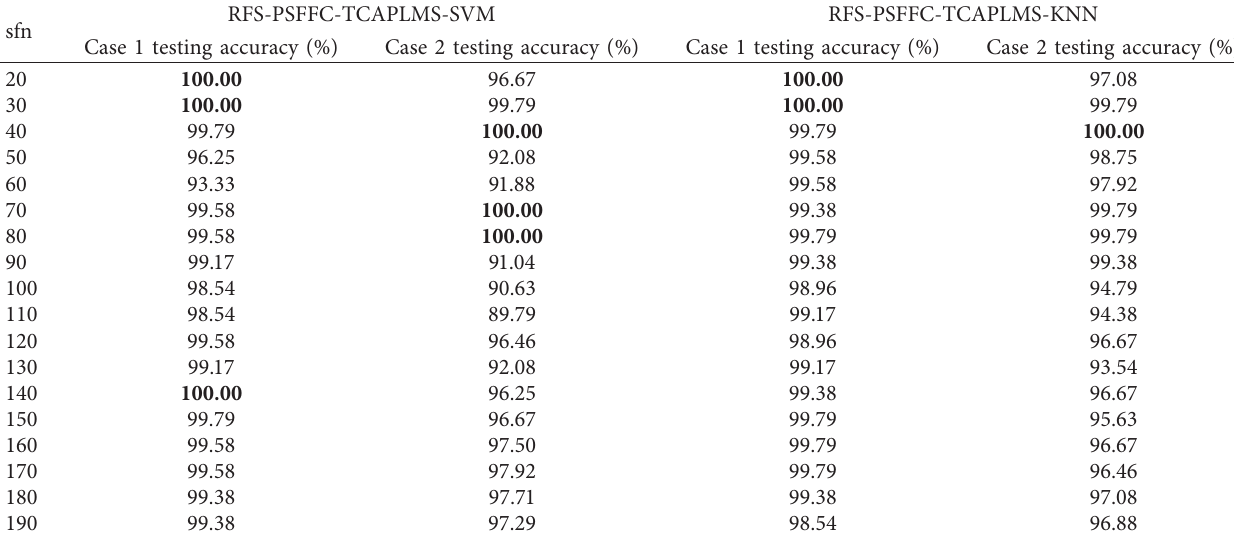
Table 12: The testing accuracies of RFS-PSFFC-TCAPLMS-SVM and RFS-PSFFC-TCAPLMS-KNN (the dimension size is 20).